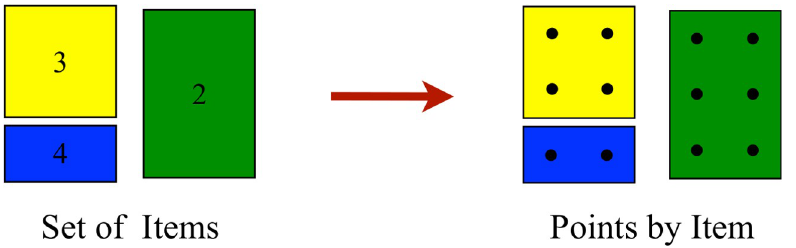
Fig 4. Points by item. The P&C methodology computes the points required for each item considering the grid inside of the bin.